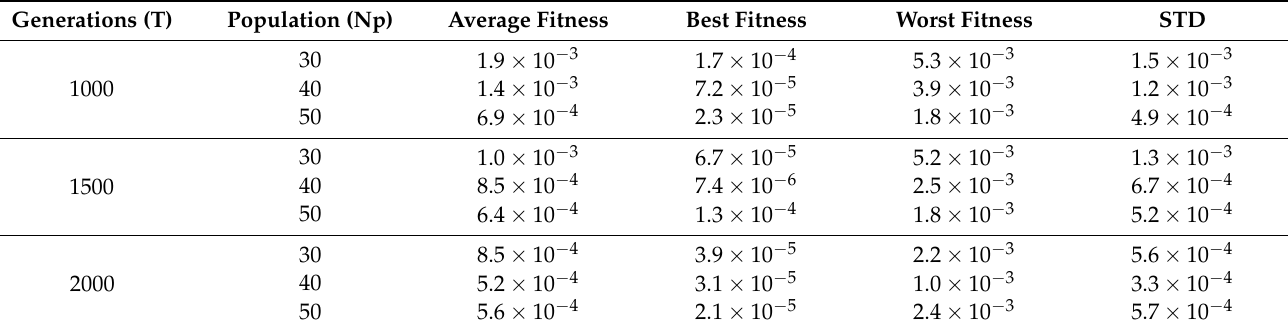
Table 8. AO parameter analysis for case 7.